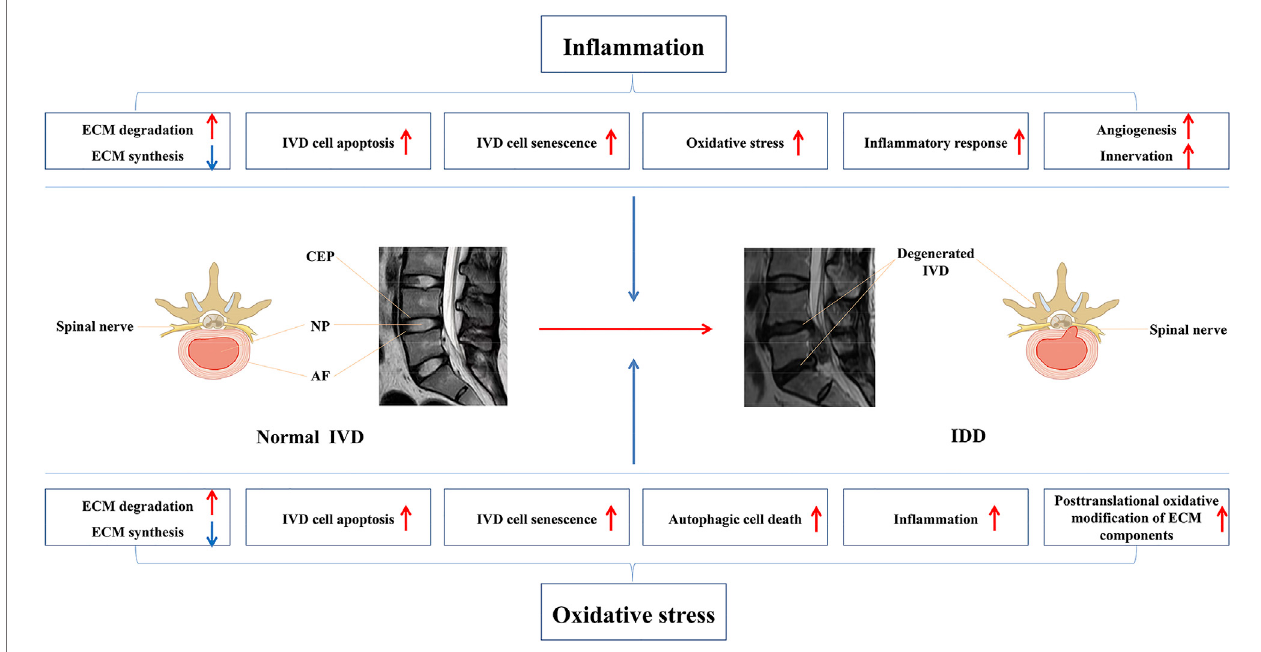
FIGURE 1 | In fl ammation and oxidative stress are involved in multiple pathological processes of IDD.